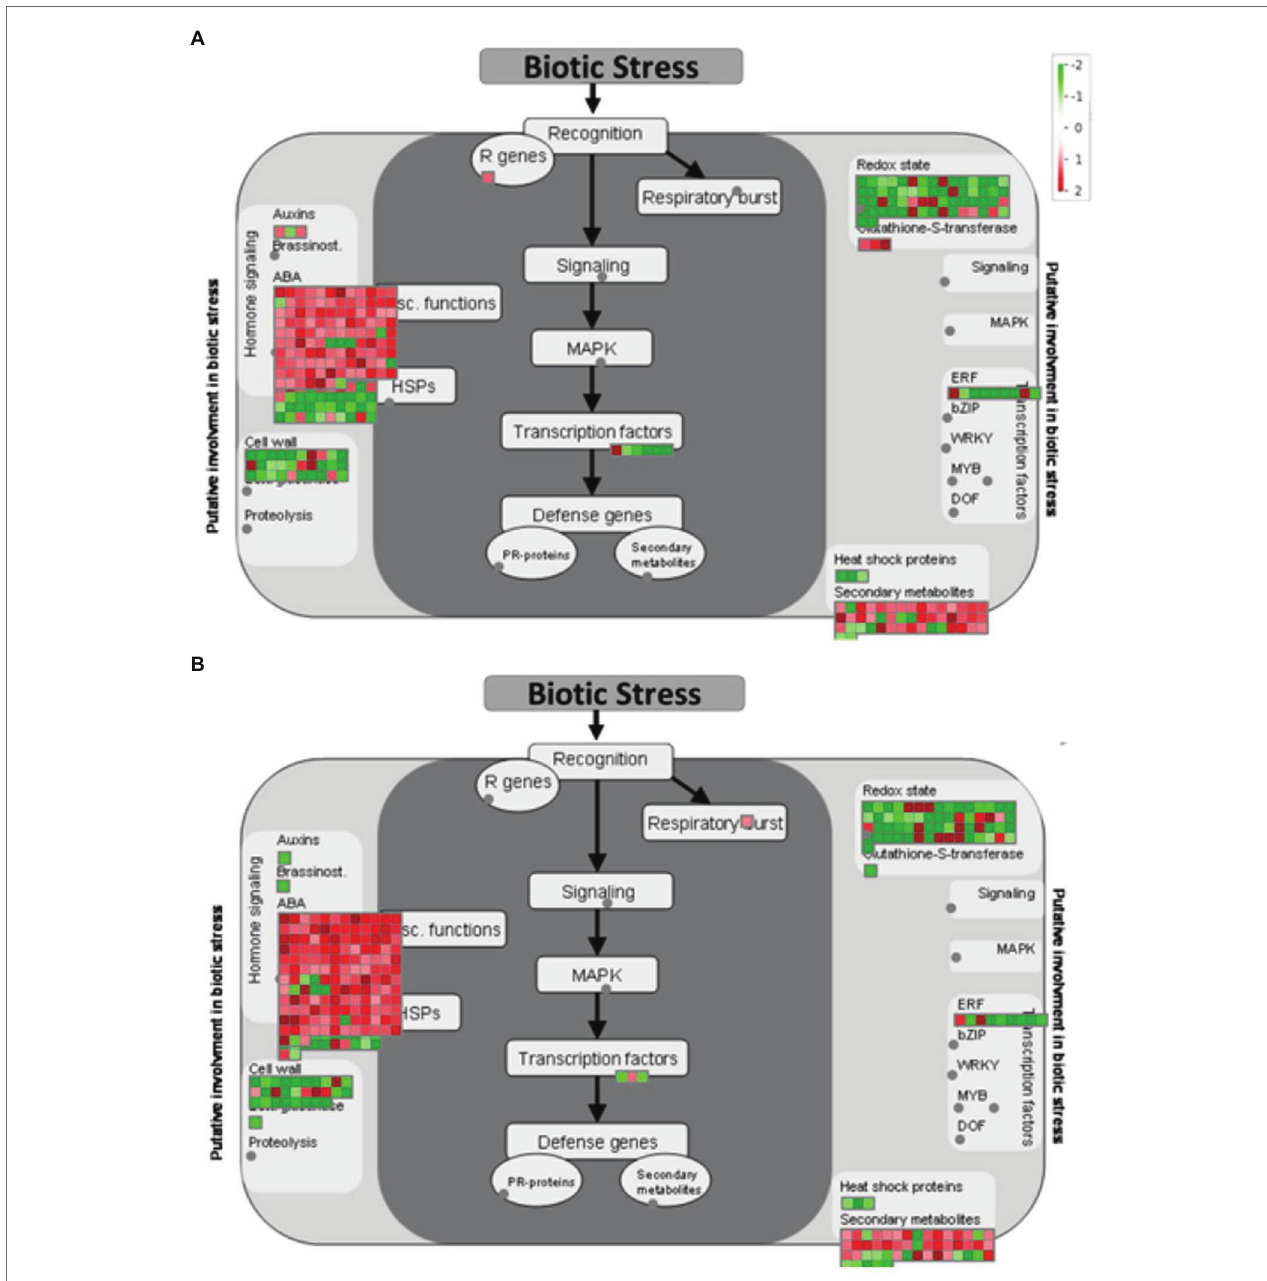
FIGURE 3 | MapMan visualization shows significant (FDR adjusted p < 0.05 and log 2 Fold > 1) DEGs mapped to the biotic stress pathway from resistant genotype QL3 (A) and susceptible genotype Theis (B) upon Johnsongrass anthracnose infection. DEGs are binned to MapMan functional categories and values are represented as log 2-fold change values. Red represents upregulated DEGs and green represents downregulated